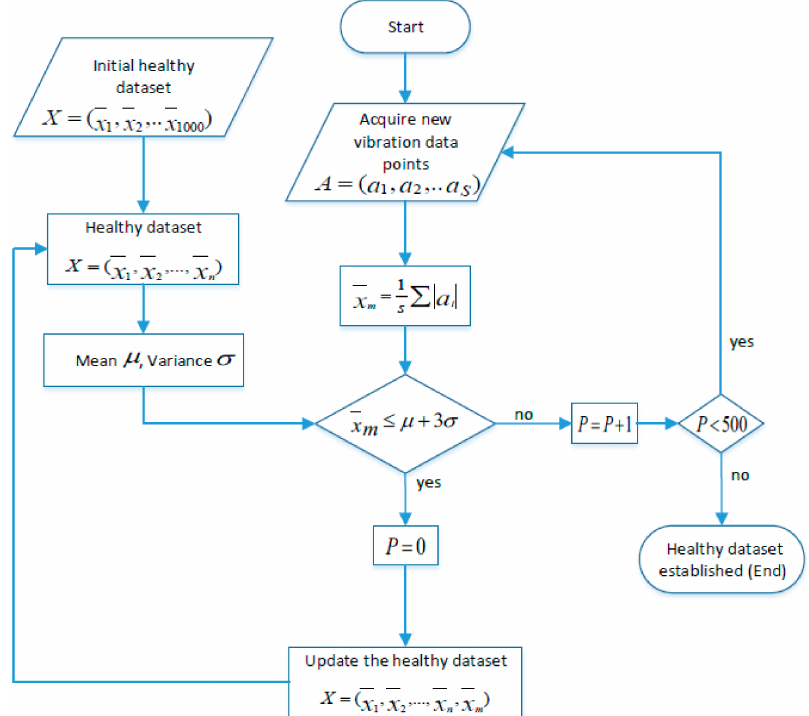
Figure 3. The flowchart of defining a failure threshold and establishing a healthy dataset. The P variable is used to count the abnormal consecutive assessment